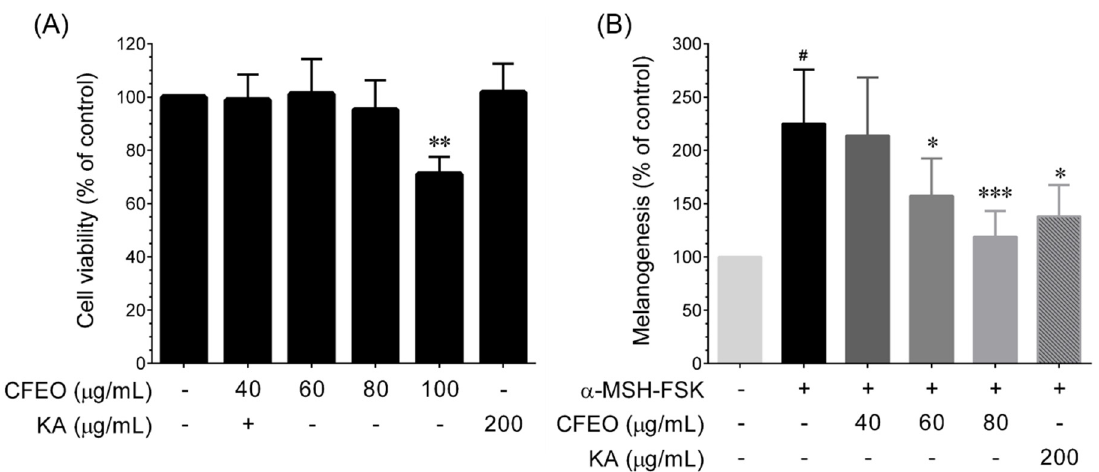
Figure 2. Effect of CFEO on α -MSH-FSK-induced melanin in B16-F10 cells. ( A ) Cells were incubated with increasing concentrations of CFEO (40–100 µg/mL) or KA (200 µg/mL) for 72 h. Cell viability was determined by MTT colorimetric assay. Data represent the mean ± SD of three independent experiments. Statistical significance was set as ** p < 0.01 compared with sample treatment groups vs. control group. ( B ) Cells were treated with increasing concentrations of CFEO or KA and stimulated with α -MSH-FSK for 72 h. The cellular melanin content was determined by colorimetric assay. Data represent the mean ± SD of three independent experiments. Statistical significance was set as # p < 0.01 compared with control vs. α -MSH-FSK and * p < 0.05, and *** p < 0.001 were significant between sample treatment groups vs. α -MSH-FSK treatment group.